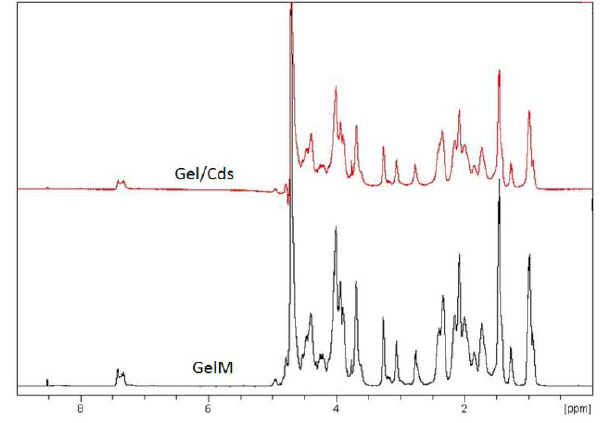
Figure 3. 1 H-NMR spectrum of gelatin and Gel/CdS.